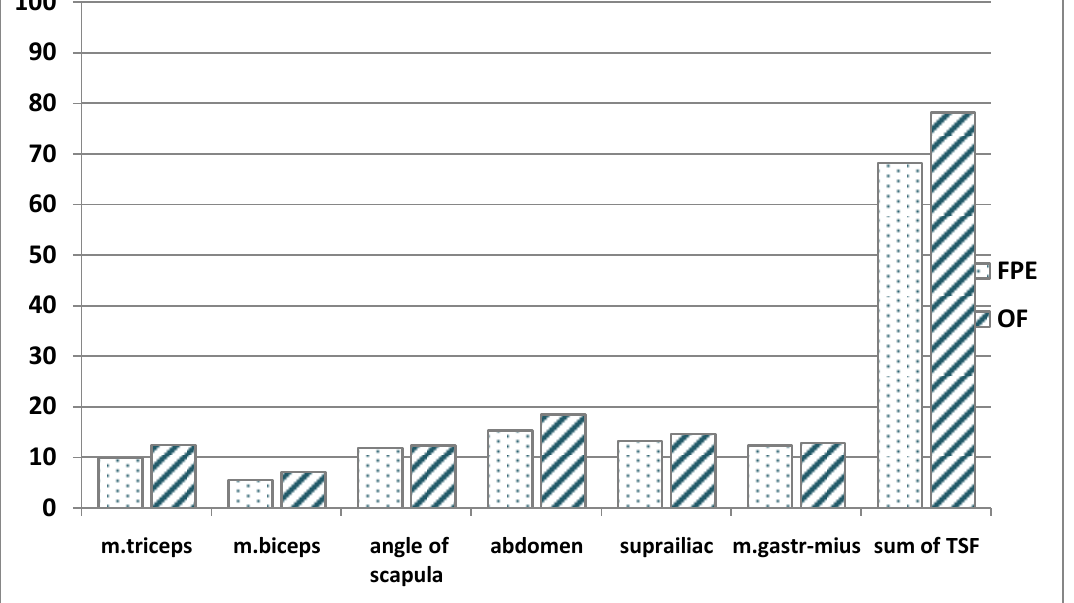
Figure 1. The mean values of the thickness of skin folds of male students at 3-4th courses studying on the faculty of physical education (FPE) and other faculties